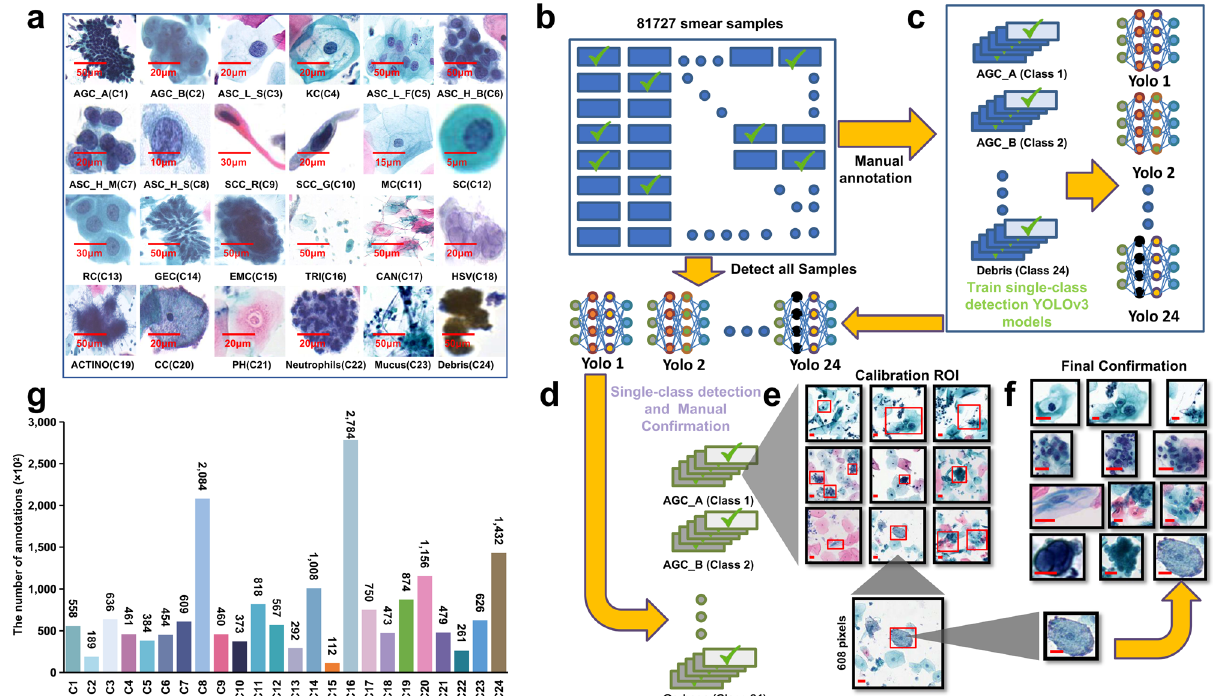
Fig. 2 Obtaining large-scale annotation dataset for deep learning. a Representative images of 24 new classi fi cations according to the TBS standard (C1 – C24 are the classi fi cation indexes during the learning). b Manually annotated 2000 images for each classi fi cation. c Training single-class YOLOv3 detection models for 24 classi fi cations. d 81727 smears were detected by 24 single-class YOLOv3 detection models, and the detected targets were manually con fi rmed. e Cytologists calibrated the ROI of right targets using annotating software, and then the annotated dataset with the corrected ROIs were obtained. (Representative images from calibration process. Scale Bars: 50 μ m). f Three cytopathologists con fi rmed the annotation data again. (Representative images from con fi rmation process. Scale Bars: 50 μ m). g The annotation number of new 24 classi fi cations (totally ~1.7 million annotated targets).